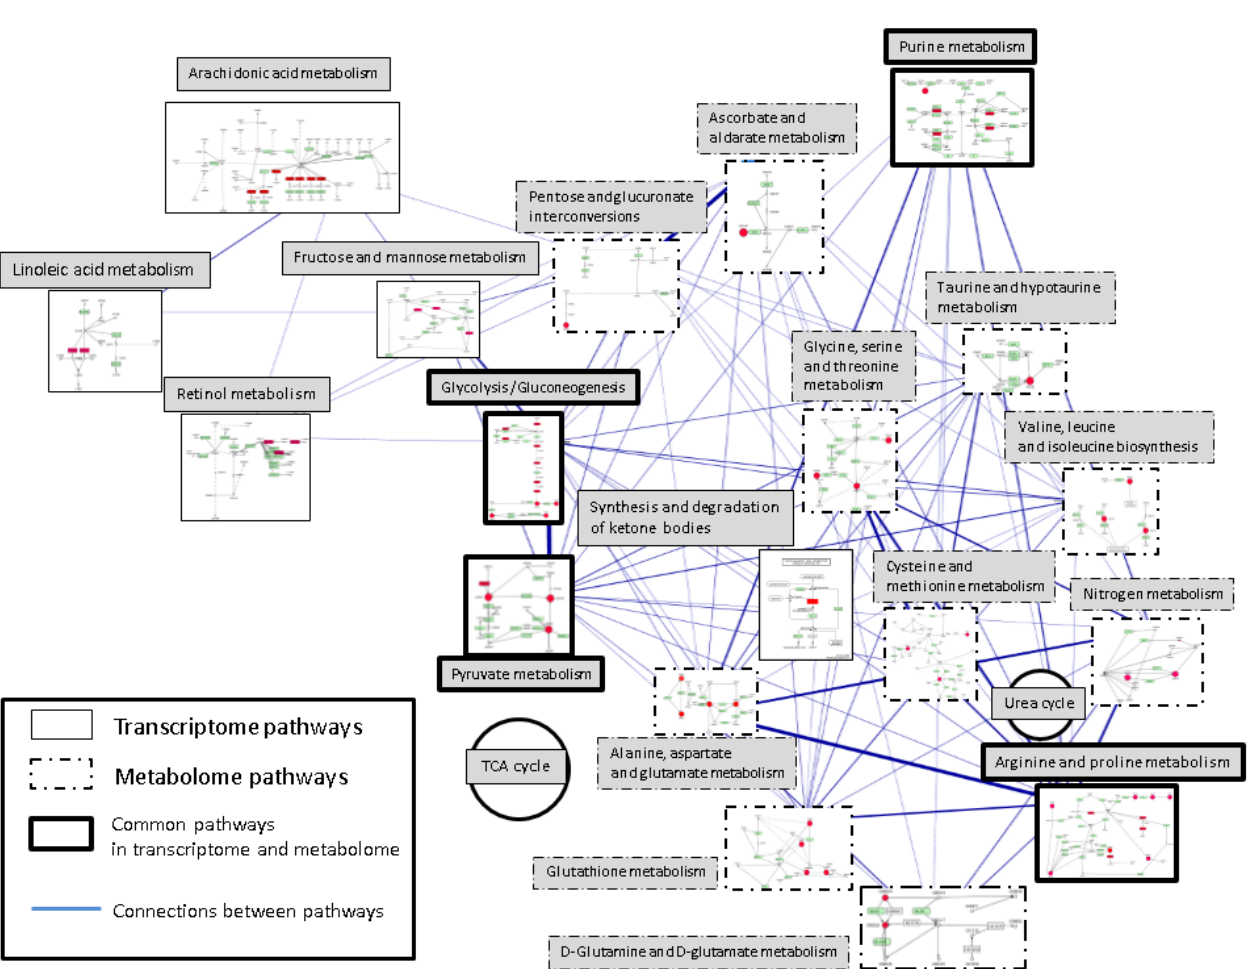
Figure 5. The pathway network of the metabolome and transcriptome. Metabolomics pathways inferred under hypoxia treatment were identified from our study. Transcriptomics pathways inferred under hypoxia treatment were obtained from the published study. Pathways on the right side of this figure including glycolysis/gluconeogenesis and pyruvate metabolism are the major changes in the metabolomic responses, and pathways on the left side including glycolysis/gluconeogenesis and pyruvate metabolism are the transcriptomic responses. Consistent pathways are ―glycolysis/gluneogenesis‖, ―pyruvate metabolism‖, ―purine metabolism‖ and ―arginine and proline metabolism‖. Each rectangle represents one metabolism with the simplified pathway route. Pathways are placed according to the KEGG global metabolism map and connected according to the shared metabolites or enzymes. Mapped enzymes or metabolites are highlighted with red color. The widths of the edges represent the number of shared metabolites or enzymes between each two pathways pair. TCA and urea cycle are also placed on the map as two